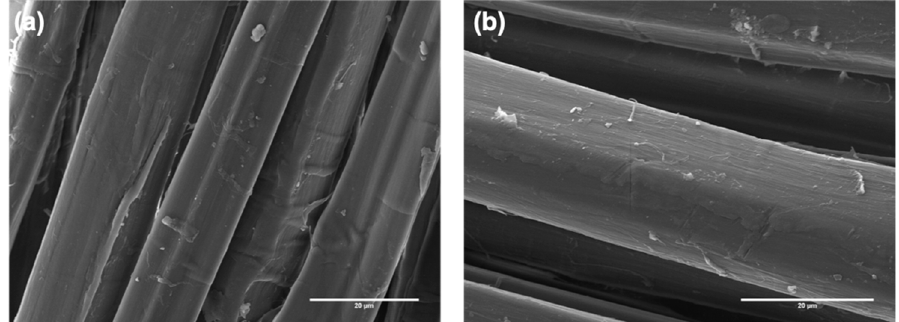
Figure 1. SEM micrographs showing untreated ( a ) flax yarn and ( b ) a close-up view of a single flax fibre.